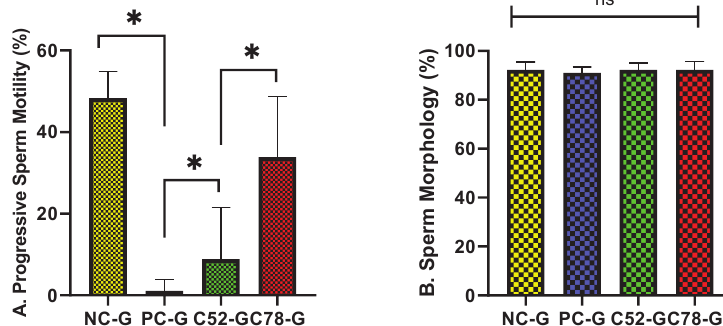
Figure 2. A. Percentage of mean of Progressive Sperm Motility; and B. Morphology in each group; * Pair wise comparrison: p<0.05; Kruskal-Wallis. ns: not significant